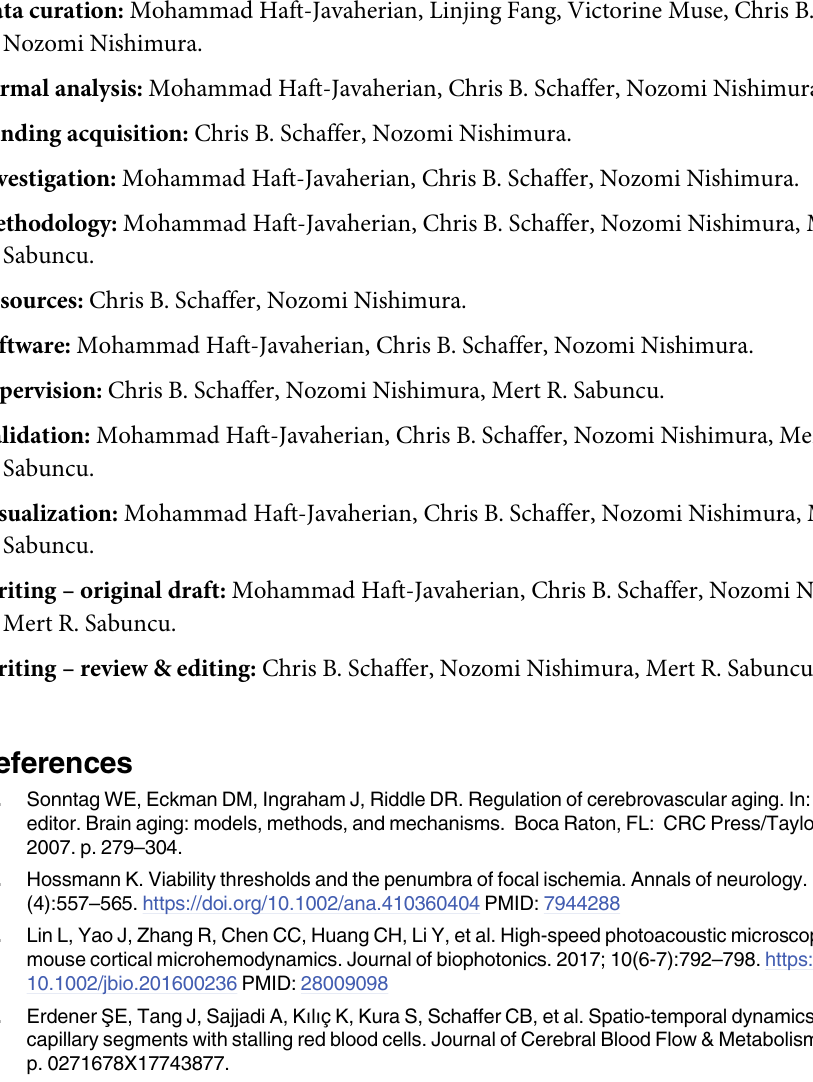
S2 Table. The results of investigating different architectures. S3 Table. The properties of six 3D images not used for training acquired from different mice included in the second independent dataset. S4 Table. The results of DeepVess and the state-of-the-art methods on the second indepen- dent dataset from subjects not used for the model training (S3 Table). DeepVess surpass both of them in terms of sensitivity, Dice index, Jaccard index, and boundary modified Haus- dorff distance